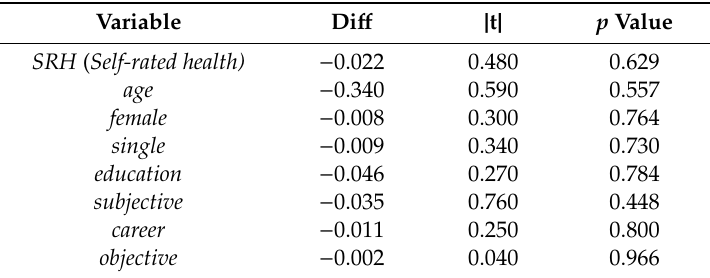
Table 9. The result of t